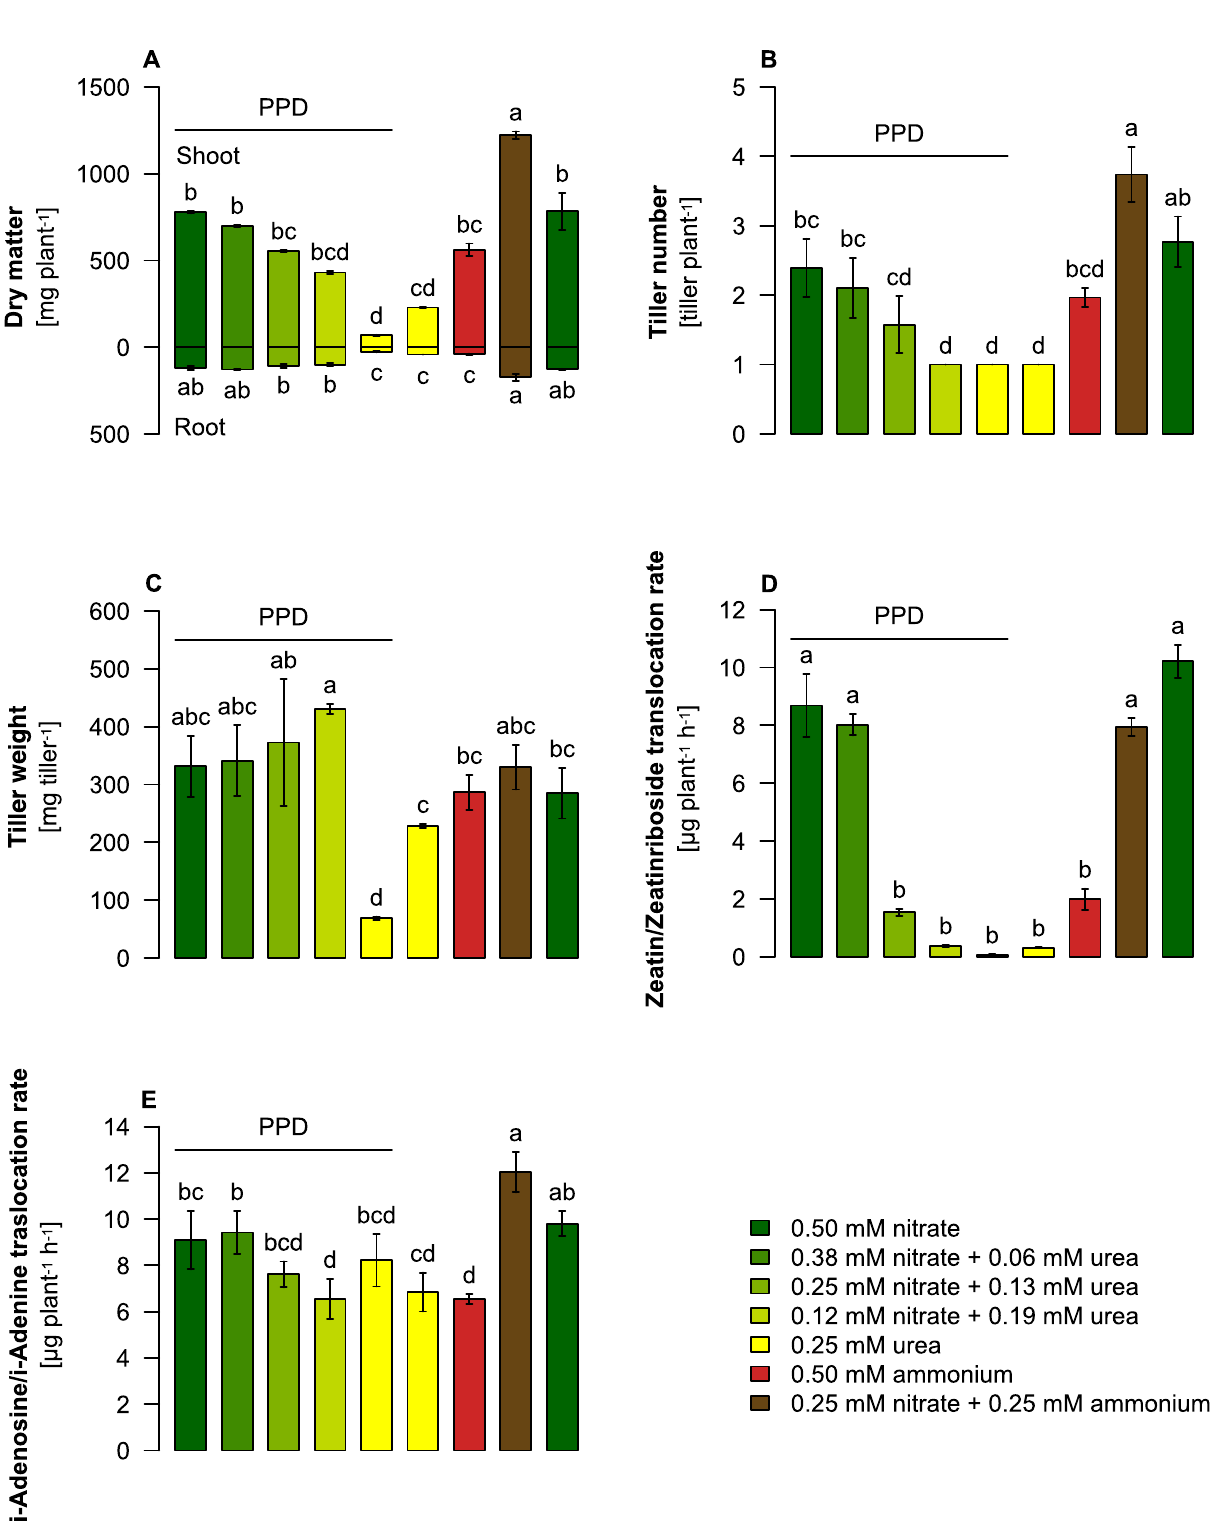
Figure 1. Dry weight, tiller number and cytokinin translocation rates in barley plants as affected by the supply of different nitrogen forms. ( A ) Dry weight per plant, ( B ) tiller number per plant incl. the primary shoot axis, ( C ) dry weight per single tiller, ( D ) root-to-shoot translocation rate of the cytokinin forms zeatin (Z) and zeatin-riboside (ZR) and ( E ) root-to-shoot translocation rate of the cytokinin precursors isopentenyl-adenine (i-Ade) and isopentenyl-adenosine (i-Ado) as determined in the xylem bleeding sap. Five days-old barley seedlings were transferred for 40 days to nutrient solution containing the following N sources: 0.5 mM KNO 3 , 0.38 mM KNO 3 + 0.06 mM urea (75:25% N), 0.25 mM KNO 3 + 0.13 mM urea (50:50% N), 0.12 mM KNO 3 + 0.19 mM urea (25:75% N), 0.25 mM urea, 0.25 mM NH 4 NO 3 . The pH was buffered at pH 6.6 by Ca(HCO 3 ) 2 , and wherever indicated 75 µg L −1 of the urease inhibitor PPD was added. Bars represent means ± SD, n = 3 biological replicates. Different letters indicate significant differences among treatments at p < 0.05 by Tukey’s